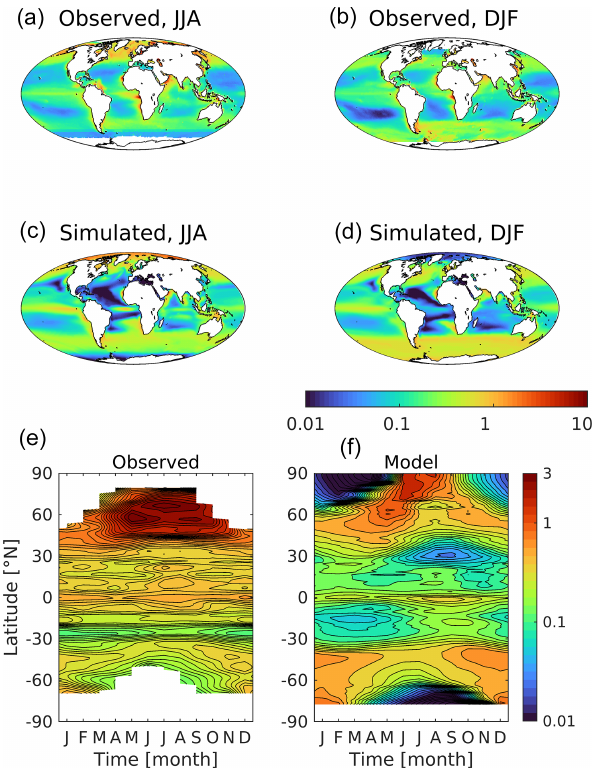
Figure 13. Observational ( a, b ; SeaWiFS) and simulated (c, d) sur- face chlorophyll shown geographically for northern ( a, c ; JJA) and southern summer ( b, d ; DJF) and as zonal Hovmöller diagrams (e, f) . Missing observational data at high latitudes because of polar night or sea ice appear as white regions in both geographical and Hovmöller panels. Concentrations are given in mgchlm − 3 .